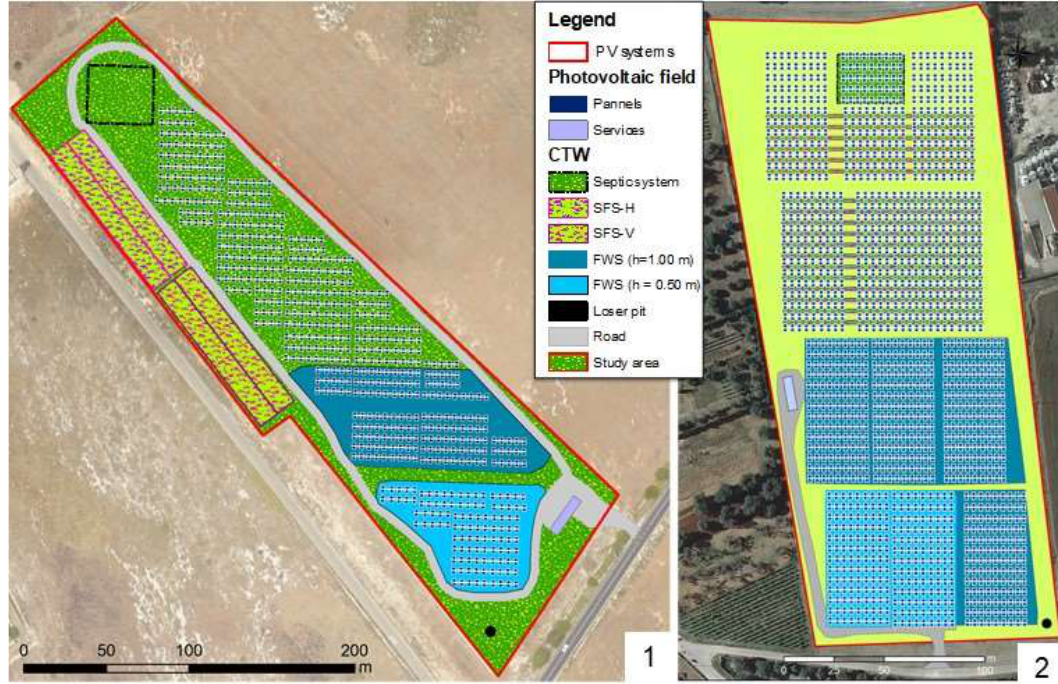
Figure 8. Maps of the two proposed Solutions 1 (in GPV system A) and 2 (in GPV system B), considering the conceptual models in Figure 5.